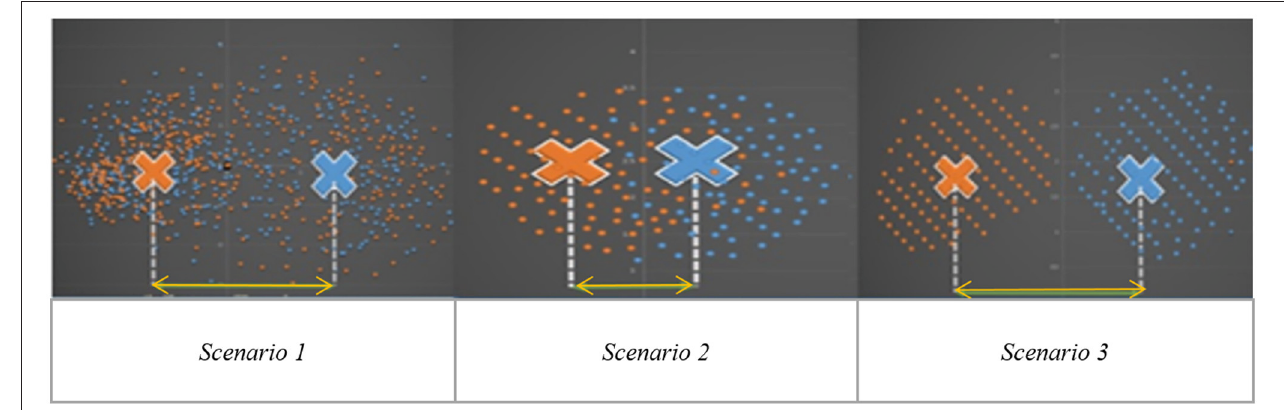
FIGURE 1 | Imaginary feature space showing three different scenarios while discriminating between two groups (indicated by two colors orange and blue): Autism and Healthy Control. Scenario 1: Significant group difference in means, say, x. Scenario 2: Non-significant difference in group means. Scenario 3: Significant mean difference comparable to x in scenario